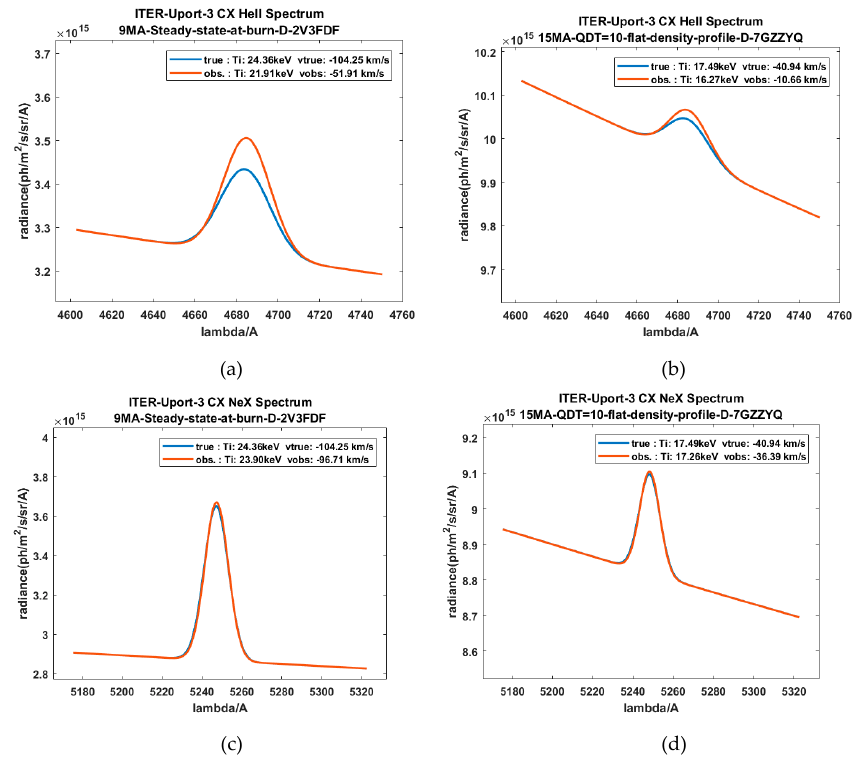
Figure 18. ( a ) SOS cross-section-effect-modeling for HeII